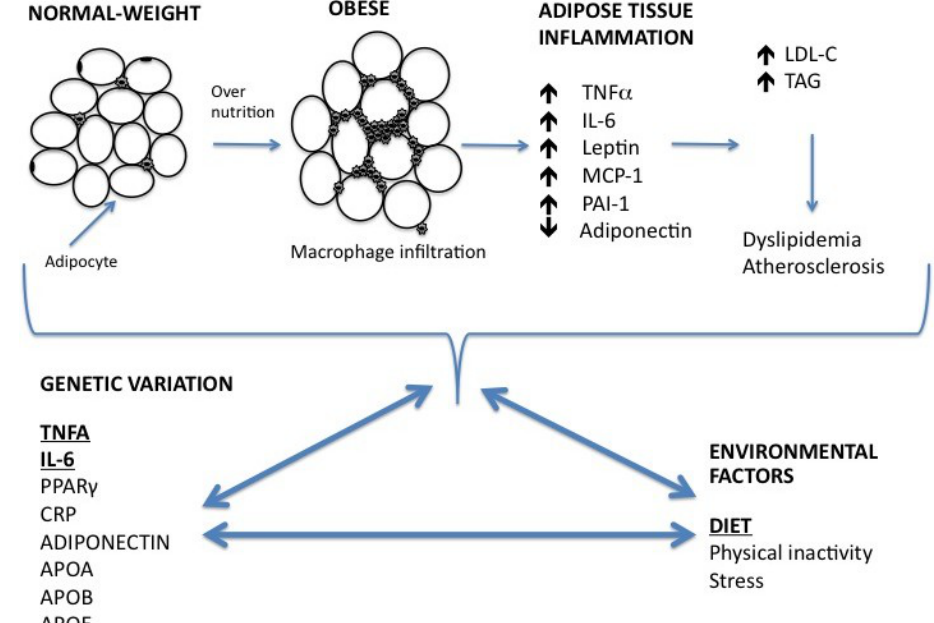
Figure 1. A proposed schematic diagram for obesity-associated low-grade inflammation, and the relationship of diet–gene interactions on obesity and dyslipidemia. Adipocytes become hypertrophic through over-nutrition. Expansion of adipose tissue in obesity leads to a subsequent increase in the production of chemokines by the adipocytes, resulting in increasing macrophage infiltration and enhanced production of pro-inflammatory cytokines, such as TNFα and IL-6. Obesity-associated low-grade inflammation results in an increase in serum trigycerides, and LDL-C concentrations and is associated with dyslipidemia. Environmental factors and DNA sequence variations in inflammatory genes, interact to impact molecular processes of the inflammatory pathway, serum lipids and the obese phenotype. APOA , Apolipoprotein A; APOB , Apolipoprotein B; APOE , Apolipoprotein E; CRP , C-reactive protein; IL-6, interleukin-6; LDL-C, low-density lipoprotein cholesterol; MCP-1, monocyte chemotactic protein-1; PAI, plasminogen activated inhibitor; PPARγ , peroxisome proliferator-activated receptor gamma; TAG, triglycerides; TNFα, tumor necrosis